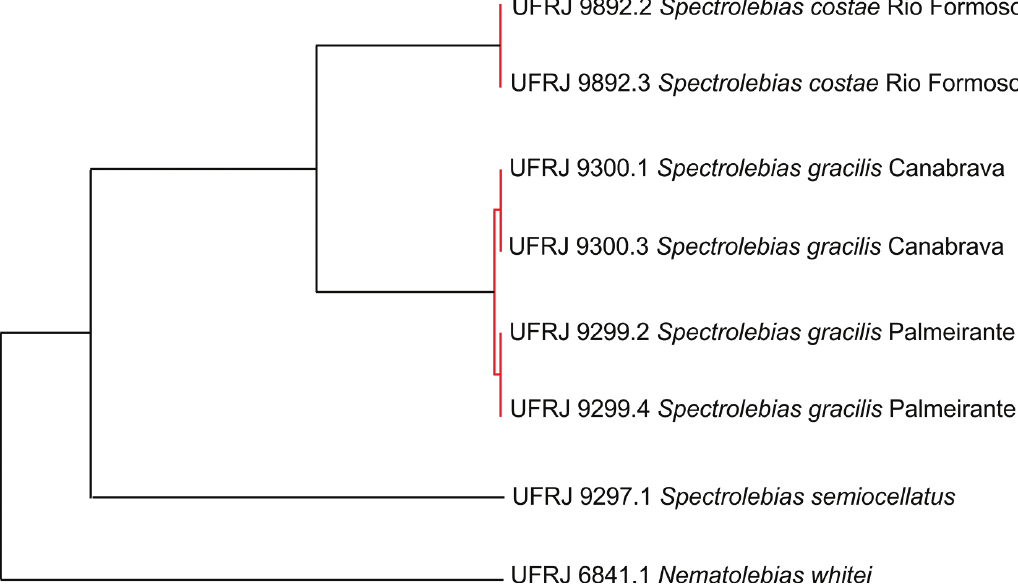
Figure 2. Species delimitation tree generated by the General Mixed Yulle Coalescent (GMYC) and the Bayesian Poisson Tree Pro - cesses (bPTP) models, using a fragment of the gene COI. Black lines indicate branching processes among species, red lines indicate branching processes within